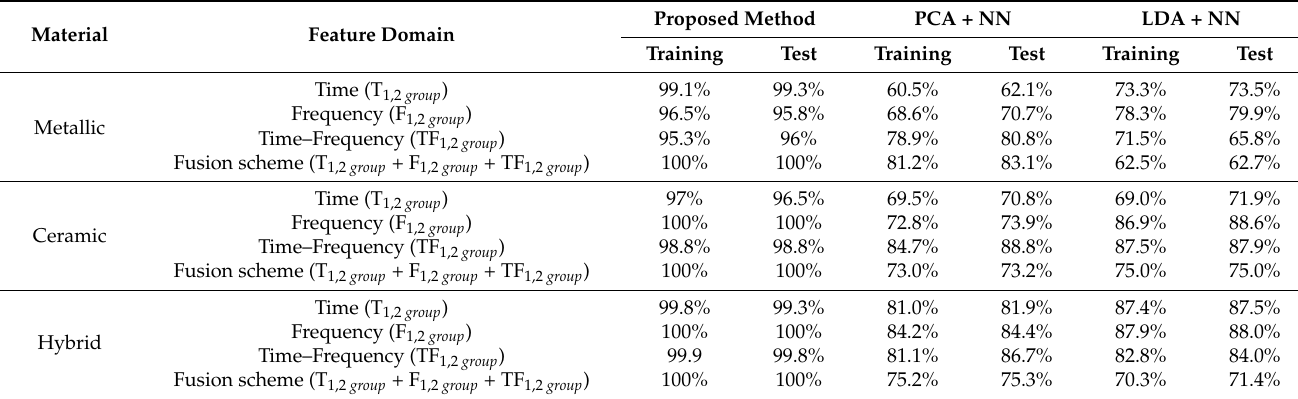
Table 7. Achieved classification ratios through the SoftMax layer for the particular evaluation of each feature domain and the proposed fusion